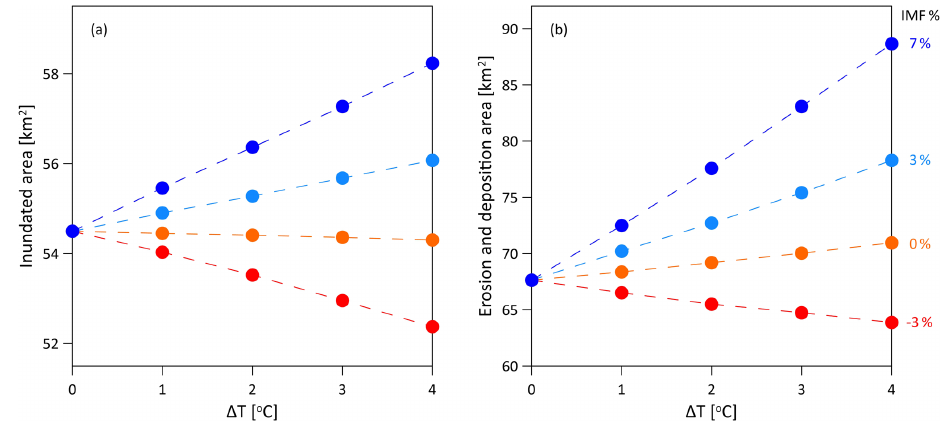
Figure 10. The sensitivity of the maximum inundated area (a) and the active erosion plus deposition area (b) to changes in the rainfall spatial structure with temperature for stratiform rainfall type. Peak rainfall intensity increases by 7% ◦ C − 1 for all points. Different colours represent mean areal rainfall intensity decrease of − 3% ◦ C − 1 (red), not changing (orange), increases of 3% ◦ C − 1 (blue), and increases of 7% ◦ C − 1 (dark blue). Reference (base scenario) for the sensitivity is the point at (cid:49)T = 0. Table 4. The hydro-morphological response produced by stratiform and convective rainfall types for the (cid:49)T = 2 ◦ C scenario in comparison to the reference scenario ( (cid:49)T = 0 ◦ C). Stratiform rainfall Convective